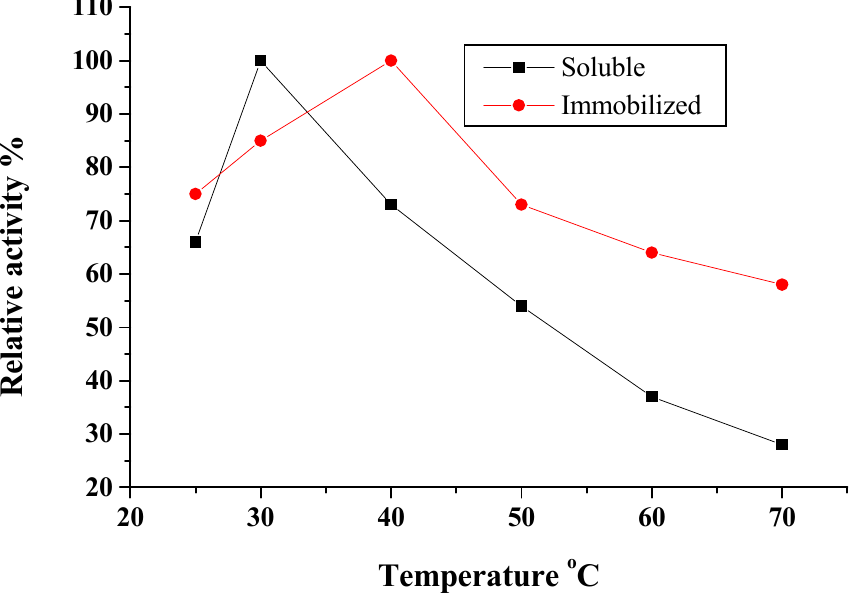
Figure 5. Optimum temperature of soluble catalase and immobilized catalase. Each point represents the average of two experiments.